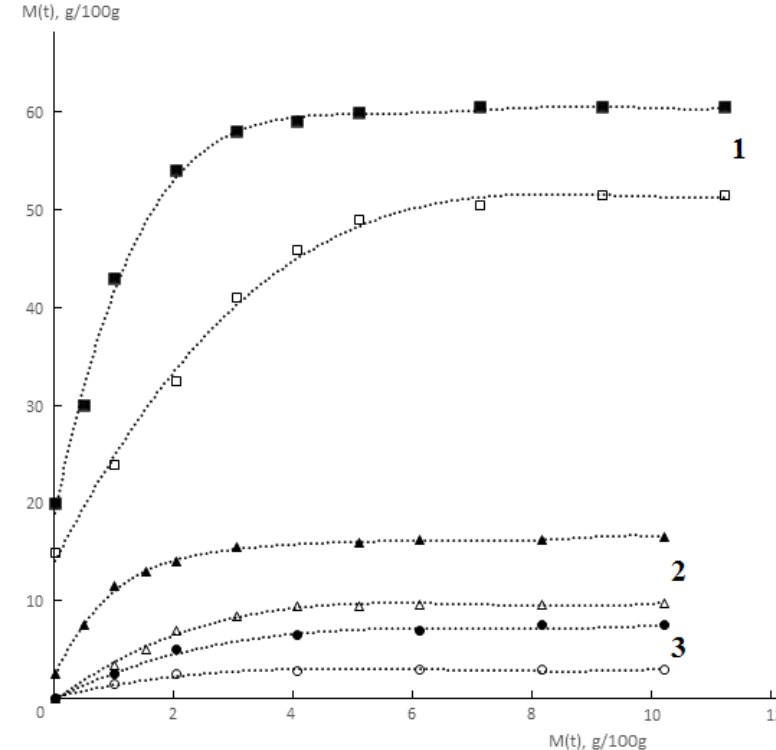
Figure 3. Kinetic curves of water vapor sorption by monolithic ( solid lines ) and porous ( dotted lines ) membranes made of collagen ( 1 ), PEU-3 ( 2 ), PEU-1 ( 3 ) at 298 K. Interval of relative water vapor pressure difference is 0.44–0.90.